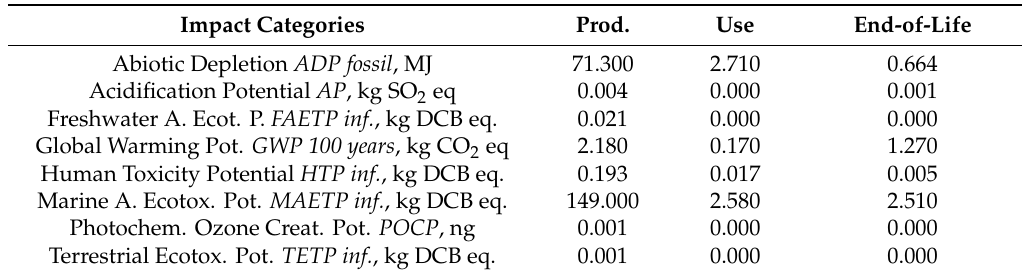
Table 5. Environmental impacts in the life cycle stages of the polypropylene product (FU: 1 kg of polypropylene product. Impact assessment method: CML